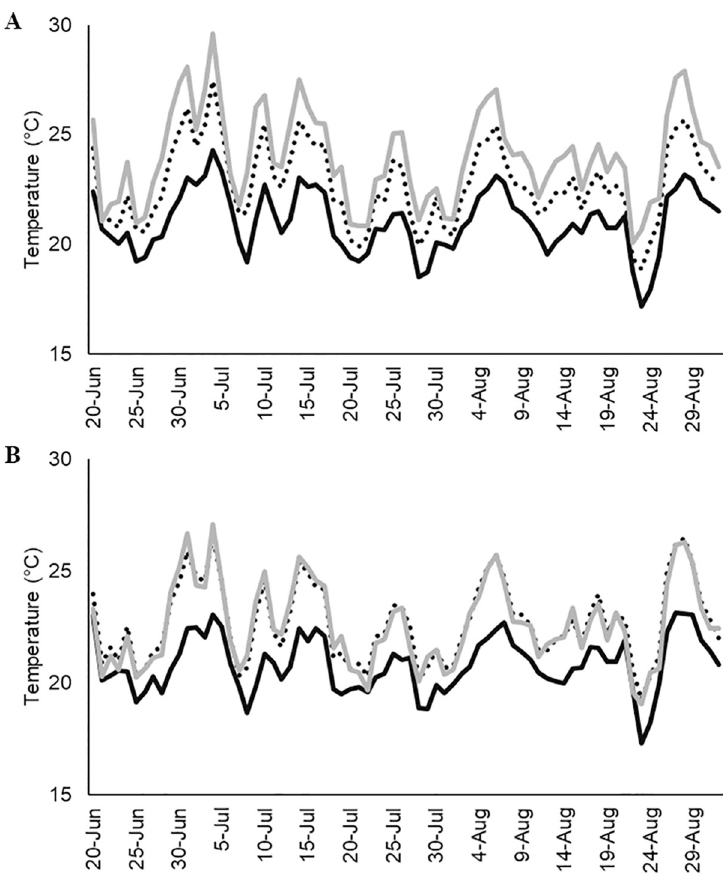
Fig 4. Average daily ambient temperatures were consistently warmer at the highest local elevations present at our two study areas, Crane Hollow Preserve (panel A) and Sunday Creek Coal (panel B) southeast Ohio from 20 June– 29 August 2018. The dark, dashed, and gray lines represent temperatures collected from the bottom, middle, and upper elevations